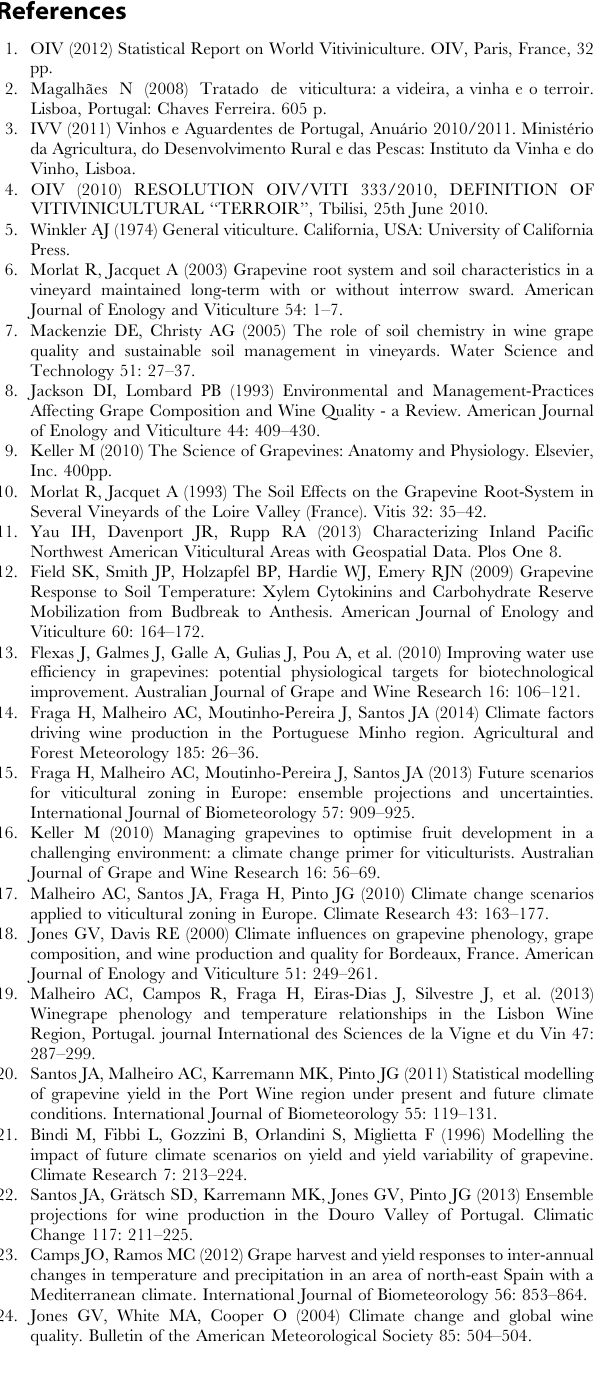
Table S2 Spearman ranked correlation coefficient be- tween the EVI, CatI, SoilT, elevation, aspect and solar radiation in all of Iberia. Table S3 Area (km 2 ) of each DO region in Iberia.